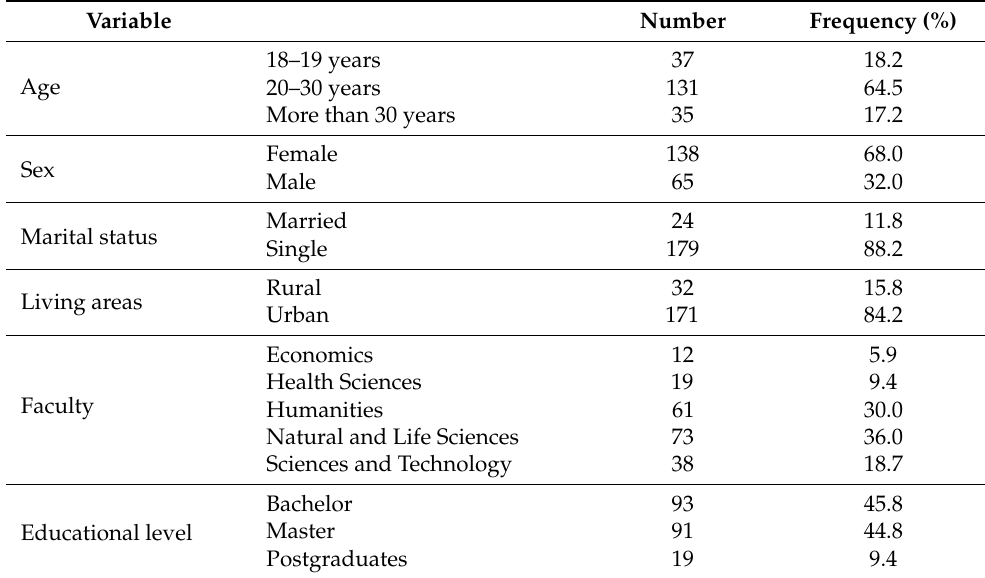
Table 1. Demographic characteristics of the study population.